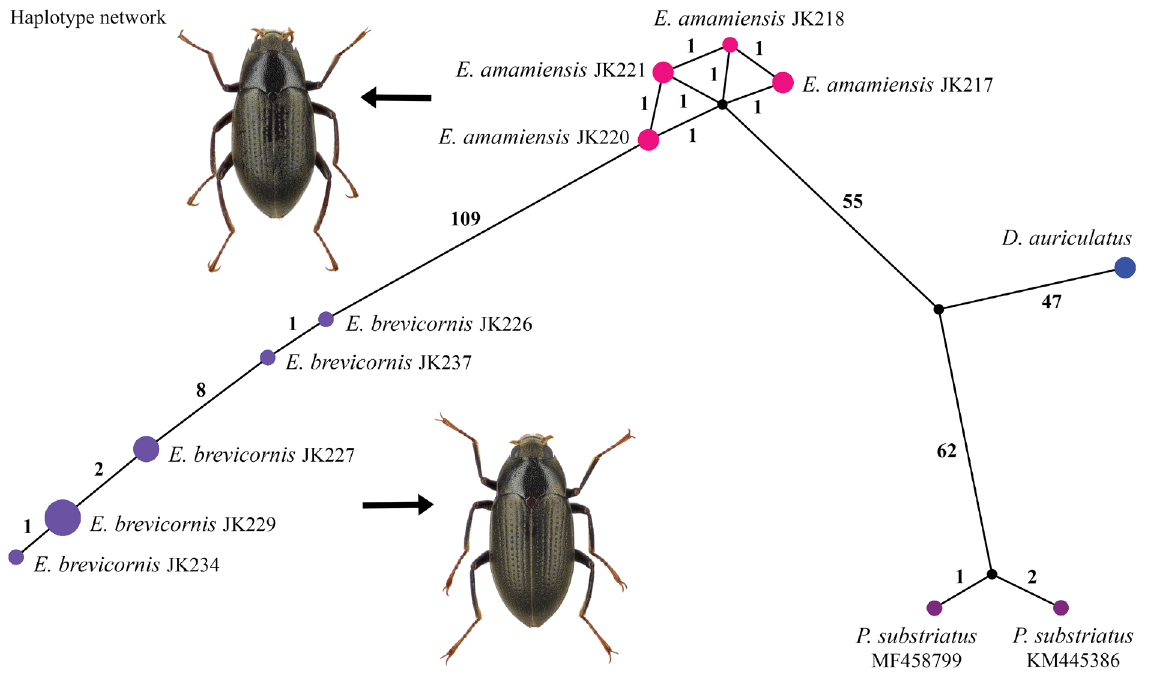
Fig. 2. TCS haplotype network of COI sequences of Elmomorphus brevicornis Sharp, 1888, Elmomorphus amamiensis Nomura, 1959 and two outgroup taxa. Numbers along edges represent mutational steps. For specimens belonging to individual haplotype groups, see Fig.